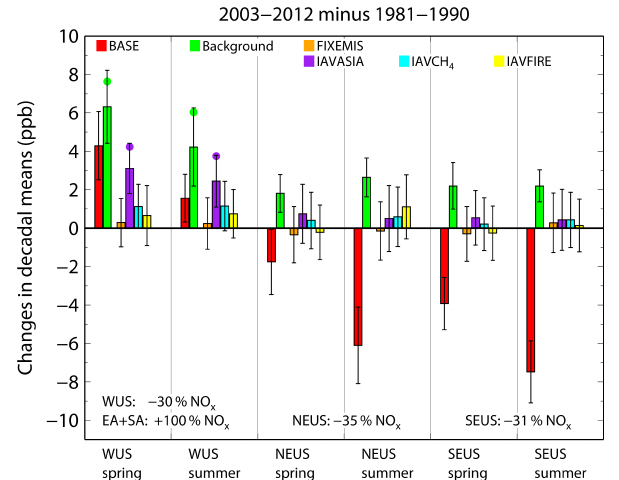
Figure 20. Summary of US surface O 3 trends and drivers. Changes in decadal mean MDA8 O 3 from 1981–1990 to 2003–2012 sim- ulated in a suite of GFDL-AM3 experiments for spring and sum- mer for the western (32–46 ◦ N and 123–102 ◦ W), northeastern (37– 45 ◦ N and 90–65 ◦ W) and southeastern (30–36 ◦ N and 95–77 ◦ W) US domains. Observations are not shown because limited data are available during 1981–1990. Experiments are color-coded, with the error bars indicating the range of the mean change at the 95% confi- dence level. Filled circles represent the changes under Background (green) and IAVASIA (purple) when filtered for Asian influence (EACOt ≥ 67th), while other results are from the unfiltered models. The text near the bottom of the plot provides the change in NO x emissions over the same period for each